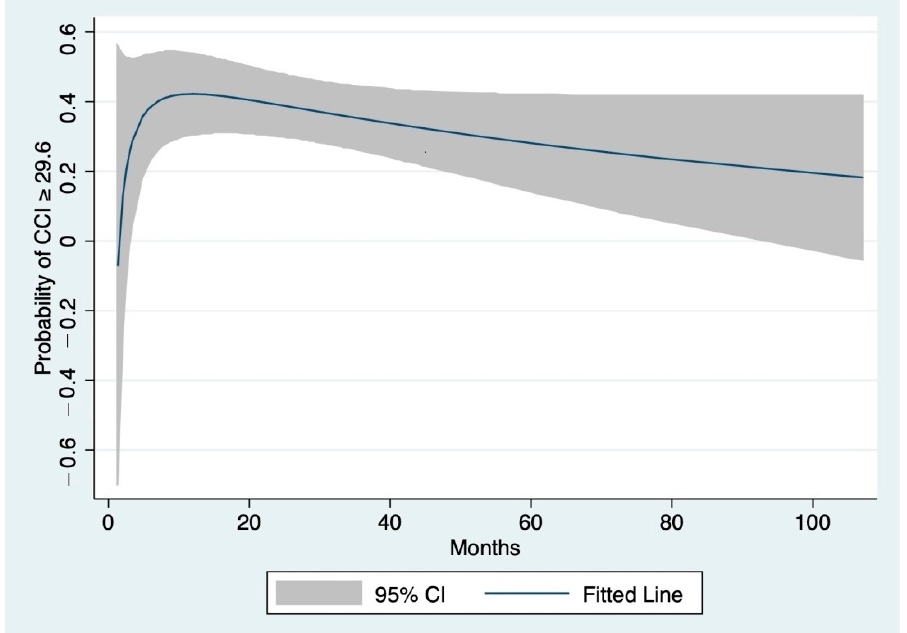
Figure 2. Relationship of the time between hepatic resection and secondary liver transplantation (time HR-SLT) with the probability of severe complications after SLT (Comprehensive Complication Index ≥ 29.6). The line was fitted using fractional polynomial regression and 95% confidence intervals are shown (gray shading).